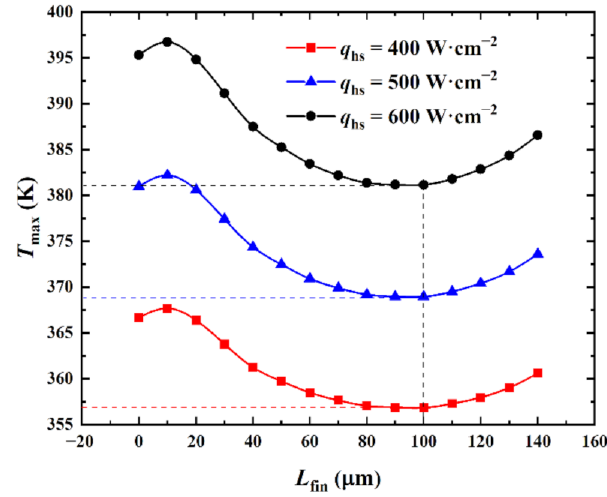
Figure 7. Effect of q hs on T max versus L fin